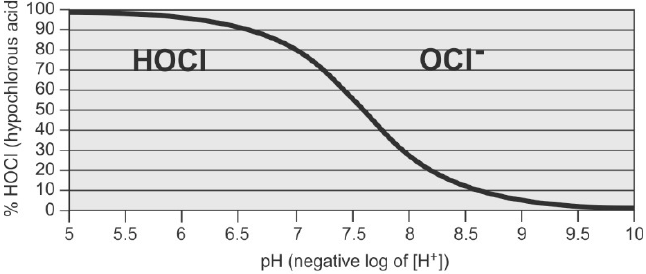
Figure 6. Speciation of chlorine, as hypochlorous acid or hypochlorite ion, in water as a function of pH at 15 °C. Courtesy of Scrivener Publishing [83].